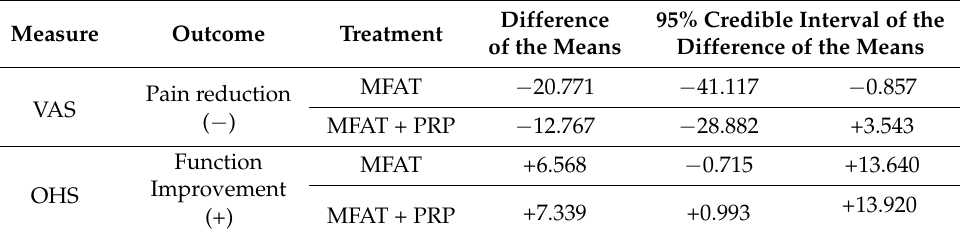
Table 4. Improvements in pain and function at 1 year after treatment of hip OA with either MFAT or MFAT + PRP.